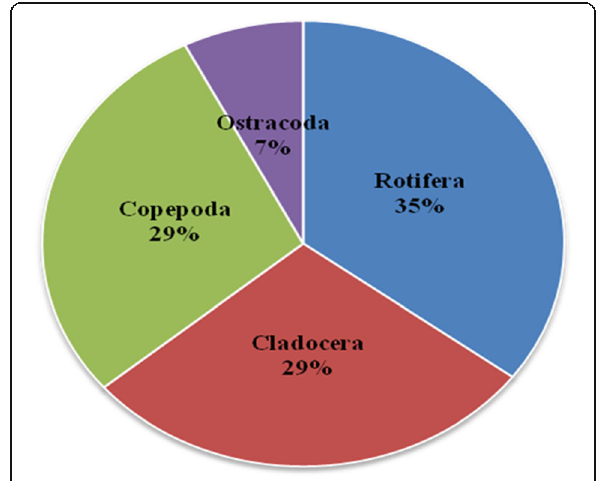
Fig. 3 Percentage composition of zooplankton recorded in the Ukkadam Lake during December 2011 – November 2012